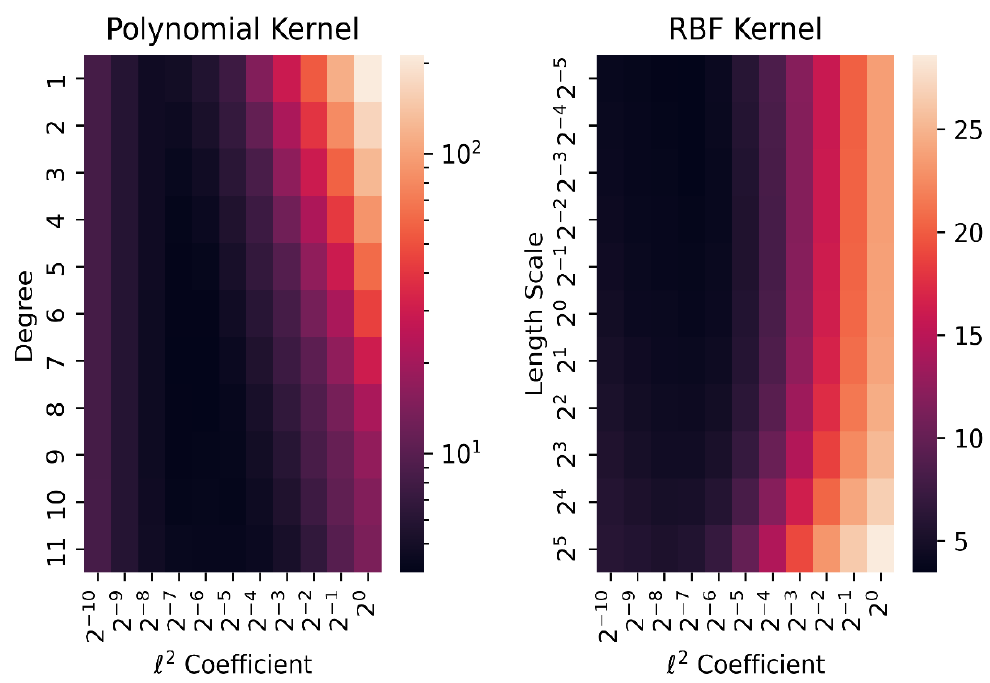
Figure 5. The effect of kernel type and its related parameters on kernel model performance.